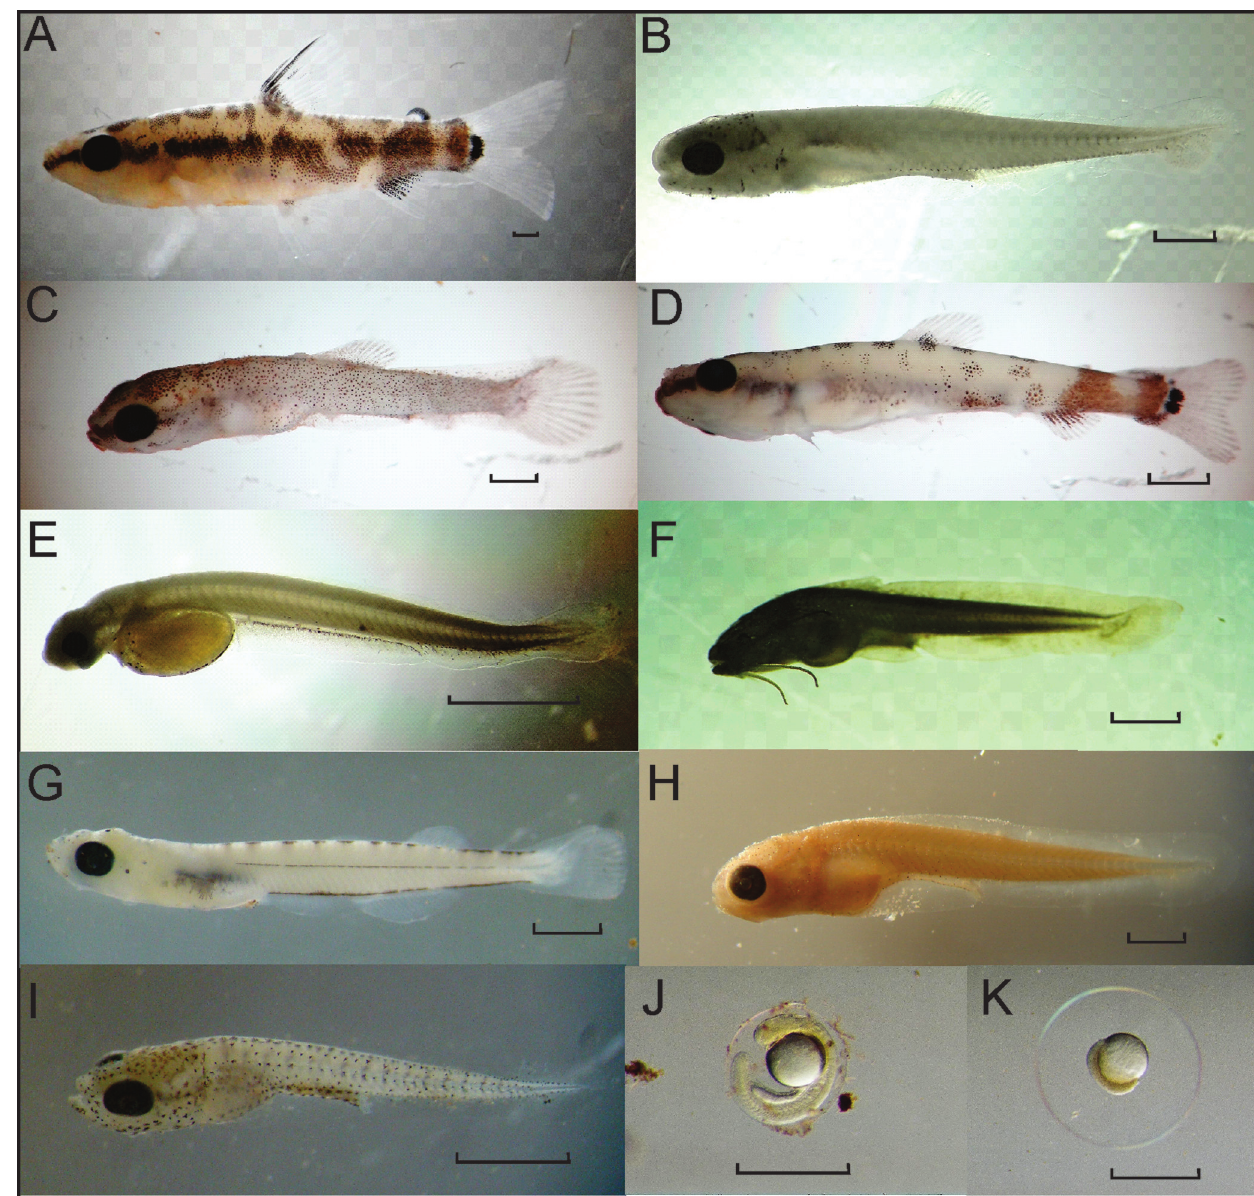
Fig. 3. Some species of fish larvae found in the upper Uruguay River: (A) Leporinus amae , (B) Bryconamericus stramineus , (C) Hoplias spp., (D) Leporinus obtusidens , (E) Schizodon aff. nasutus , (F) Rhamdia quelen , (G) Odontesthes aff. perugiae , (H) Serrasalmus maculatus , (I) Astyanax jacuhiensis , (J) Steindachnerina spp. egg and (K) Apareiodon affinis egg (Scale =